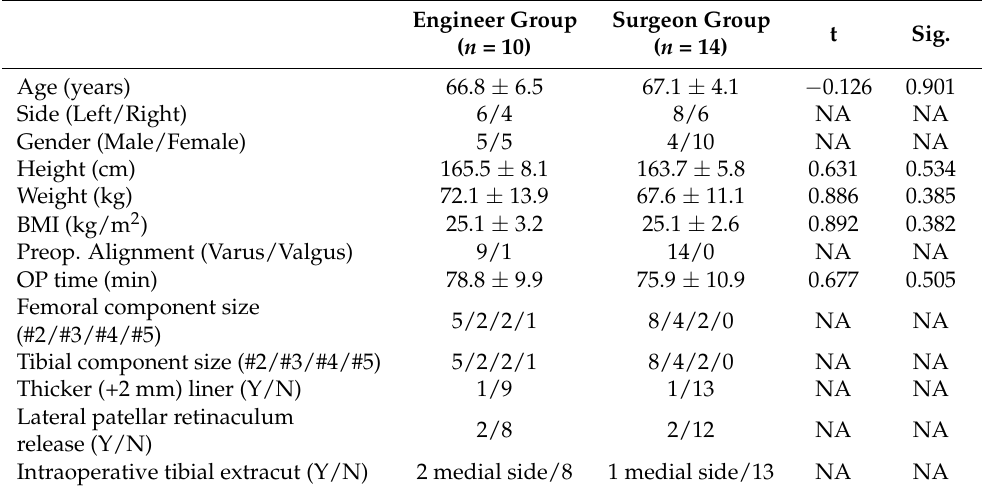
Table 1. Preoperative patient demographics and other parameters of engineer-designed PSI group and surgeon-designed PSI